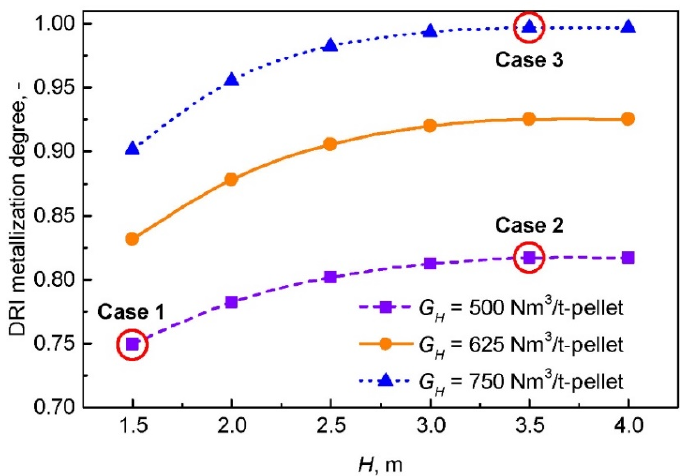
Figure 4. Effect of upper-row injection distance ( H ) on DRI metallization degree at different injection rates ( G H ).